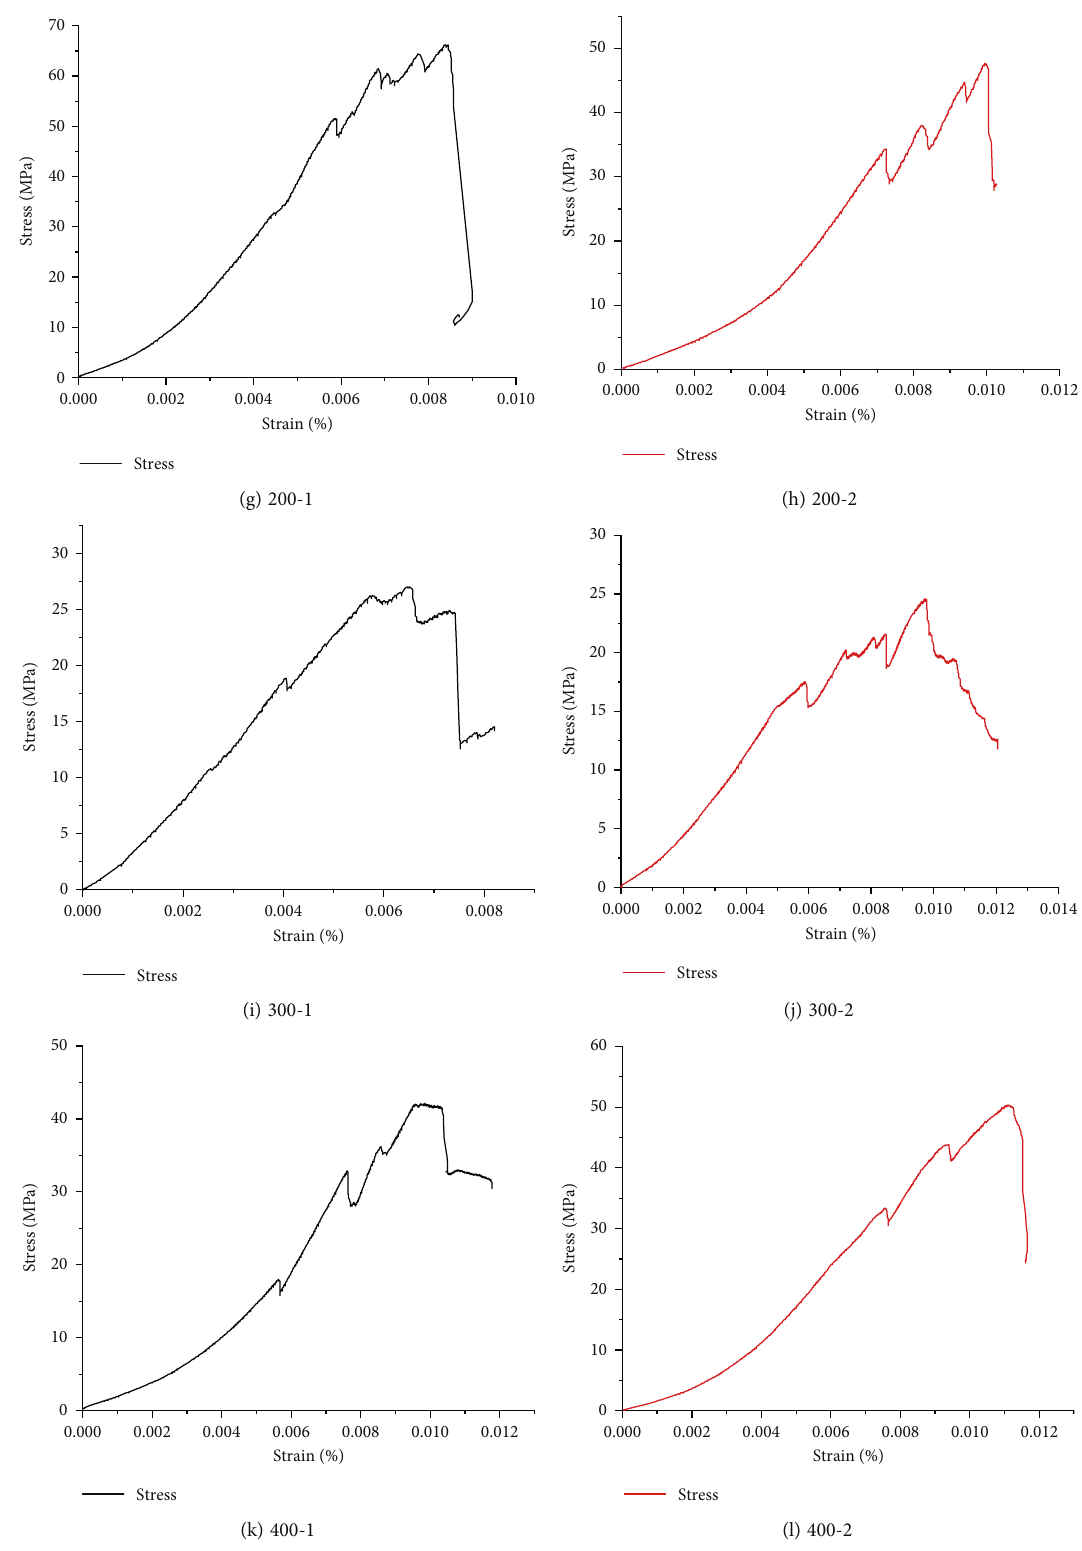
Figure 1: The stress-strain curves of twelve rock